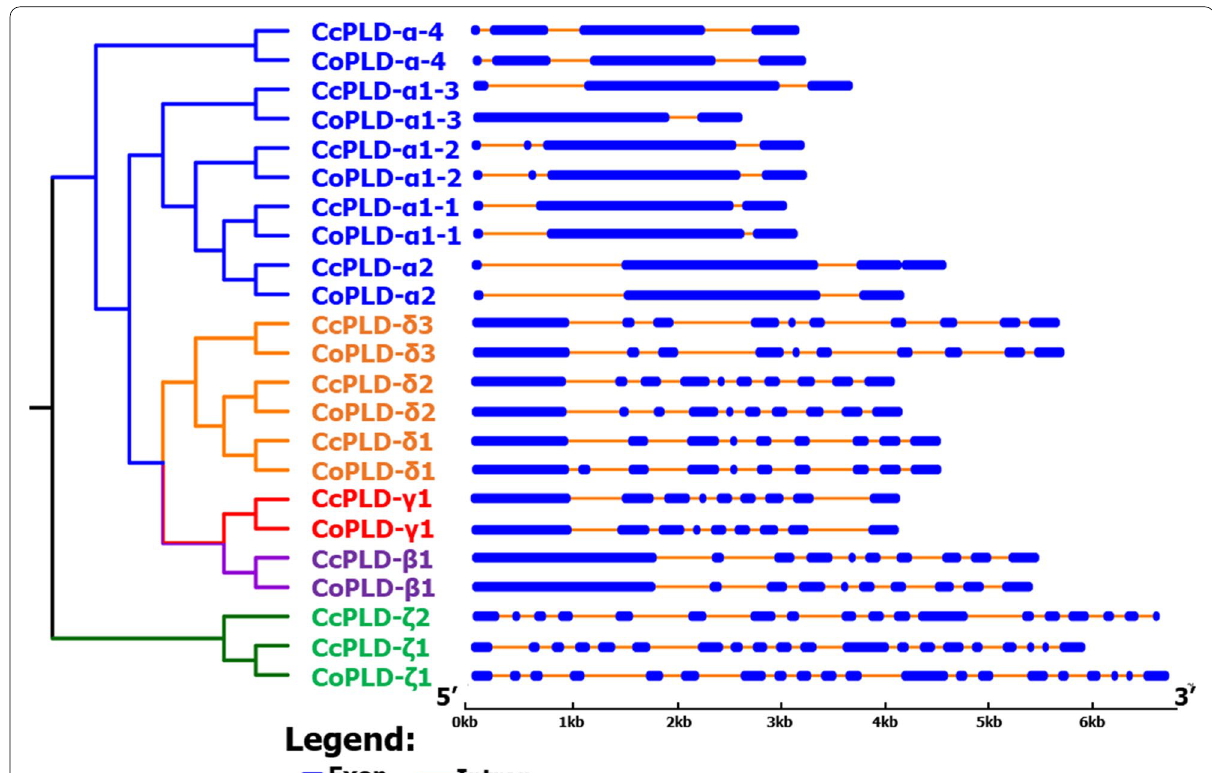
Fig. 2 Exon-intron structure of 23 PLD genes of C . capsularis and C . olitorius . Exons are shown in blue color and introns are in black